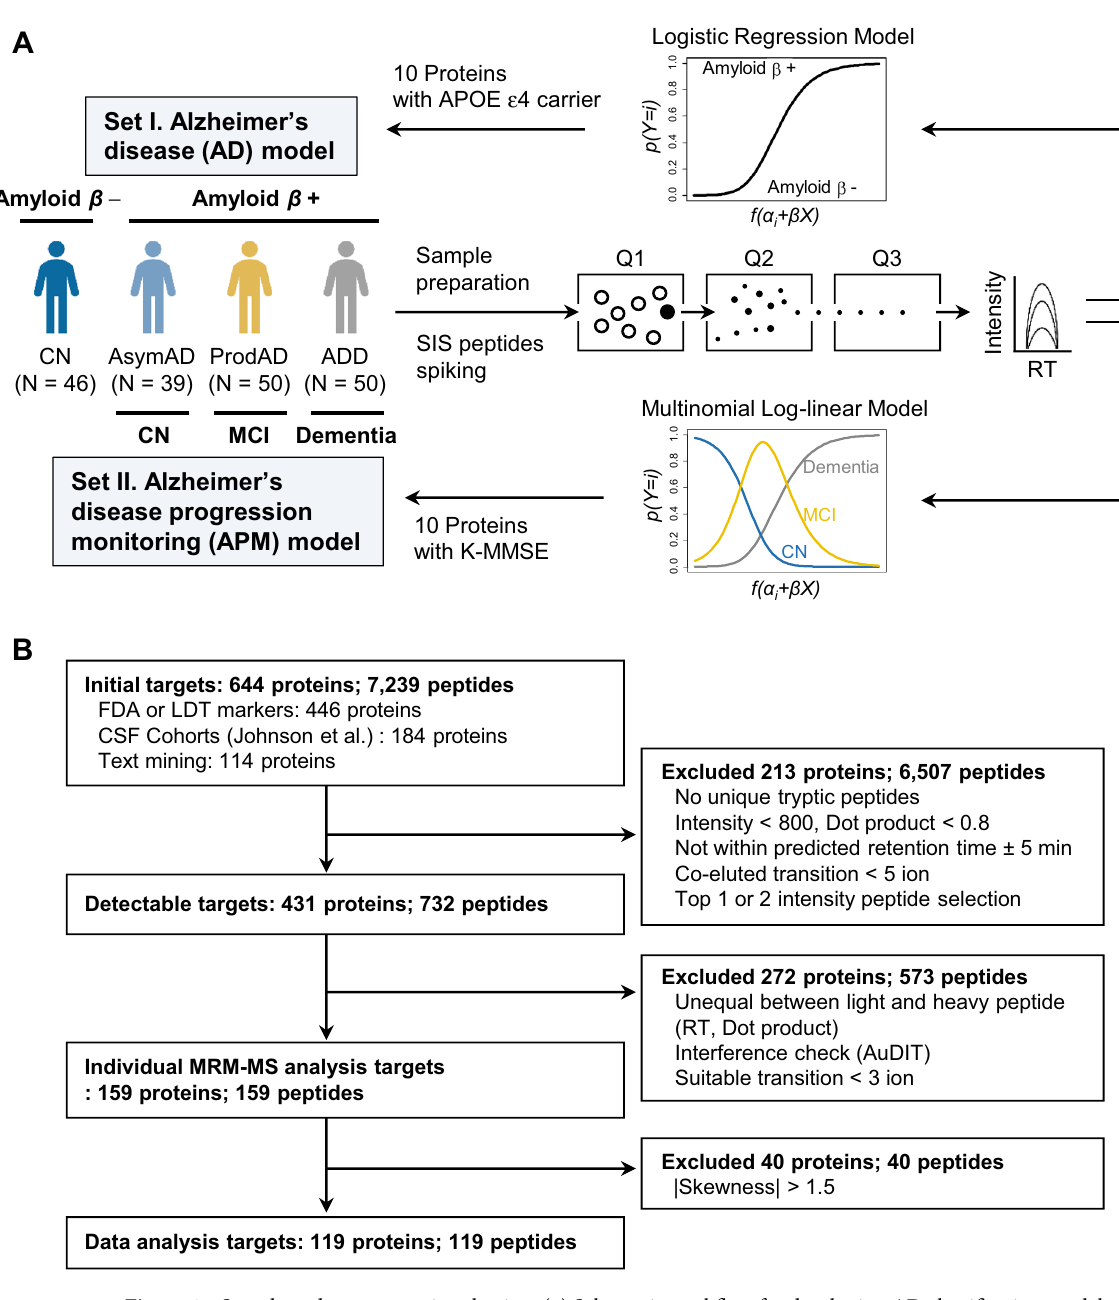
Figure 1. Sample and target protein selection. ( a ) Schematic workflow for developing AD classification model using multiple reaction monitoring-mass spectrometry and multinomial log-linear regression. 10 proteins and APOE genotyping results were selected as features for the Alzheimer disease model, and 10 proteins and K-MMSE scores were used for construction of the Alzheimer disease progression monitoring model. ( b ) Target protein selection workflow. A total of 644 proteins were compiled from three types of resources; 431 proteins that were detectable by MRM-MS analysis were selected. Quality of quantitation was assessed by evaluating the interference from SIS peptides. Ultimately, 159 peptides representing 159 proteins were selected for individual sample analysis, of which 119 were selected for data analysis, based on the skewness of the